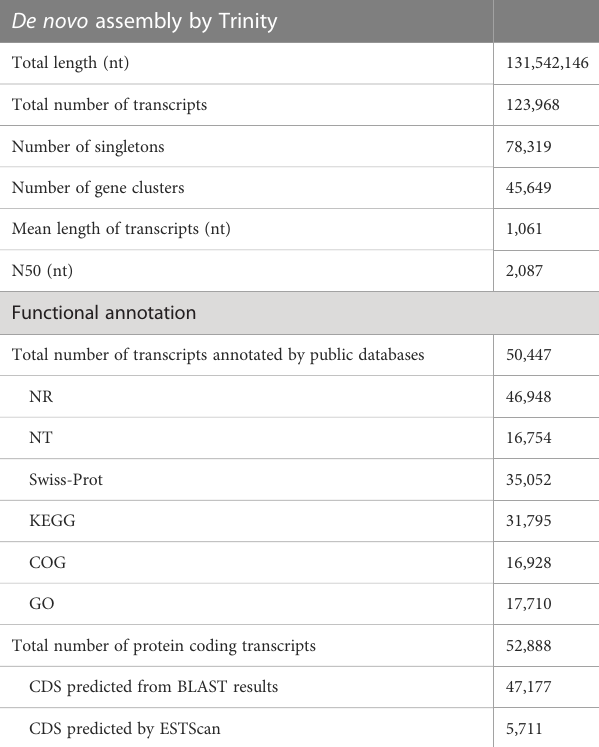
TABLE 2 Summary of De novo assembling and functional annotation of Acropora pruinosa transcriptome. De novo assembly by